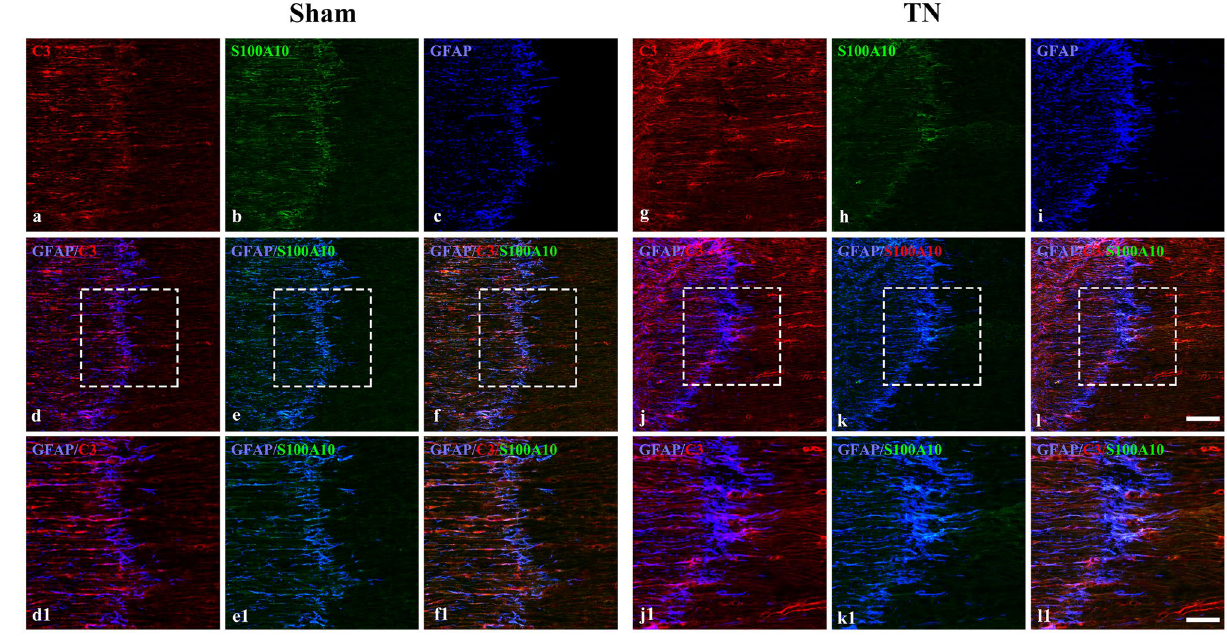
Figure 2. Immunofluorescence staining of A1- and A2-reactive astrocytes in the TREZ on POD 28. ( a – c ) and ( g – i ) Immunofluorescence staining of reactive astrocytes in the TREZ in the two groups. ( d , j ) show GFAP/ C3-positive A1 astrocytes in the TREZ. ( c , k ) show GFAP/S100A10-positive A2 astrocytes in the TREZ. ( f , l ) show triple immunofluorescence staining of GFAP, C3 and S100A10. ( d1 – f1 ) and ( j1 – l1 ) show the higher magnification of ( d – f ) and ( j – l ). ( a – l ). scale bar = 100 μm. ( d1 – f1 , j1 – l1 ), scale bar = 50 μm.